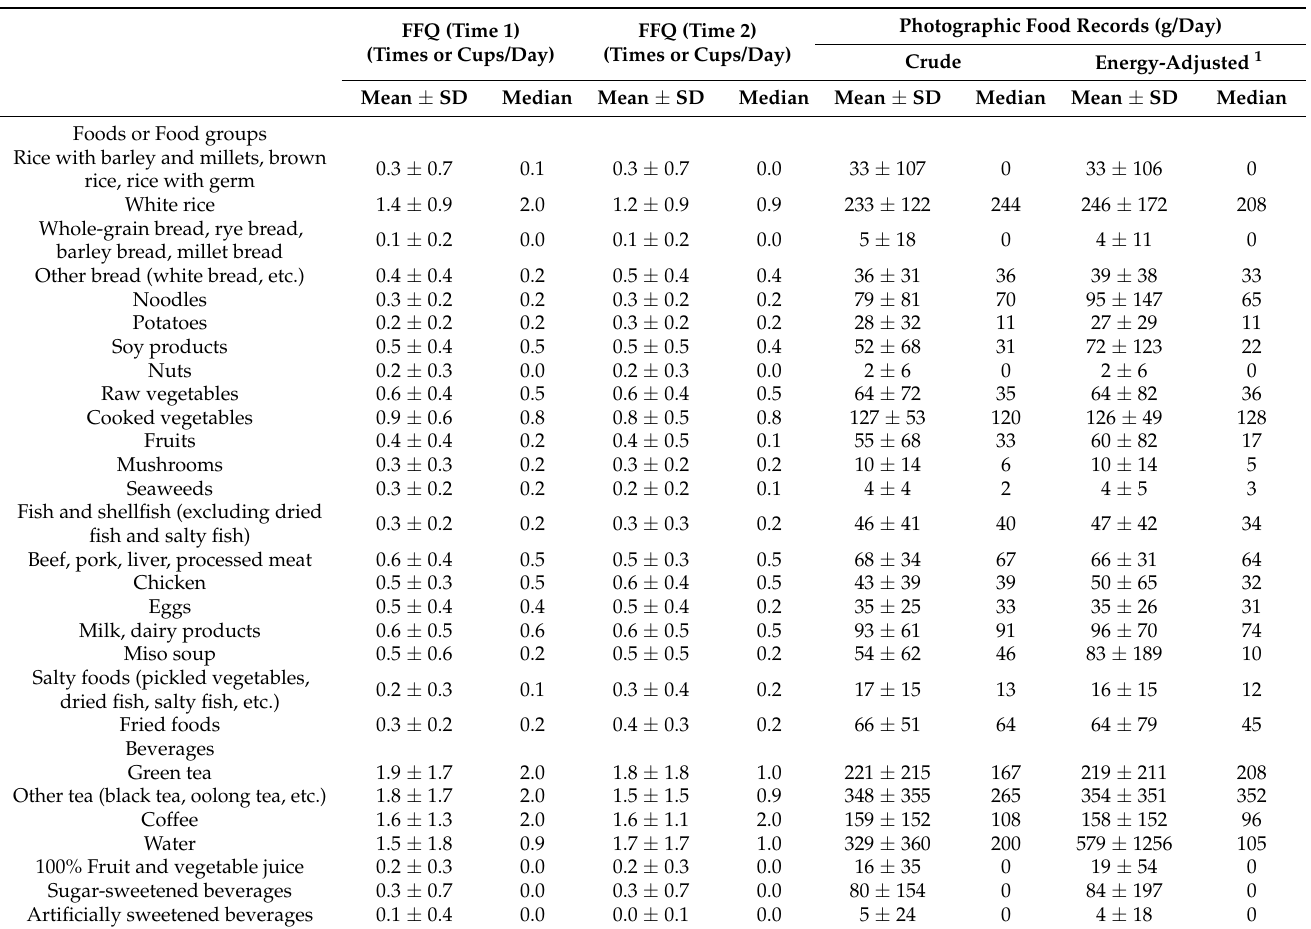
Table 1. Consumption frequency of food groups based on two FFQs one week apart and food group intakes based on a 3-day photographic food record in 9 males and 15